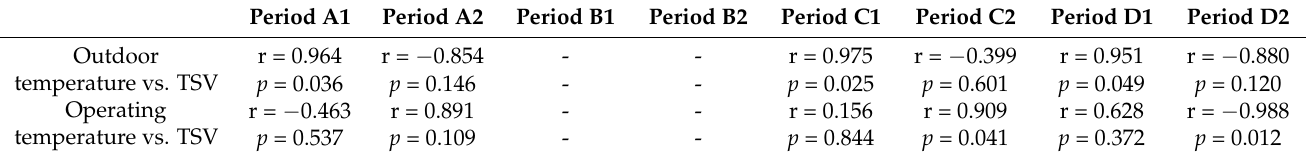
Table 9. Correlation between outdoor temperature, operating temperature, and TSV.